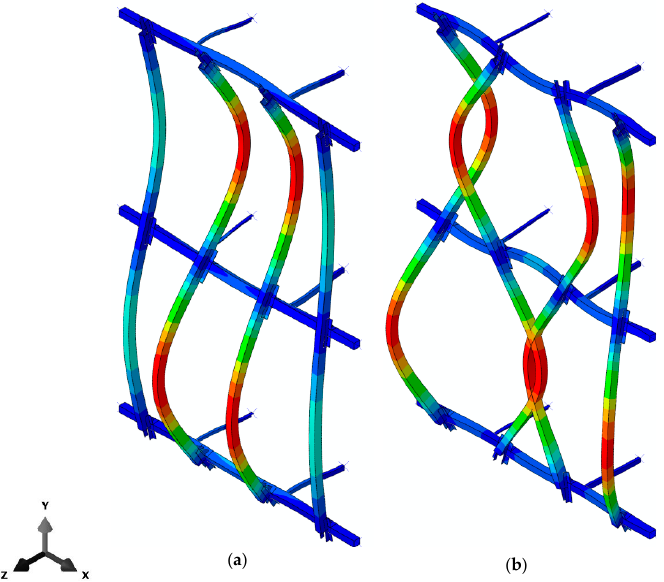
Figure 11. The second ( a ) and fourth ( b ) natural mode shapes. Colors indicate the displacement